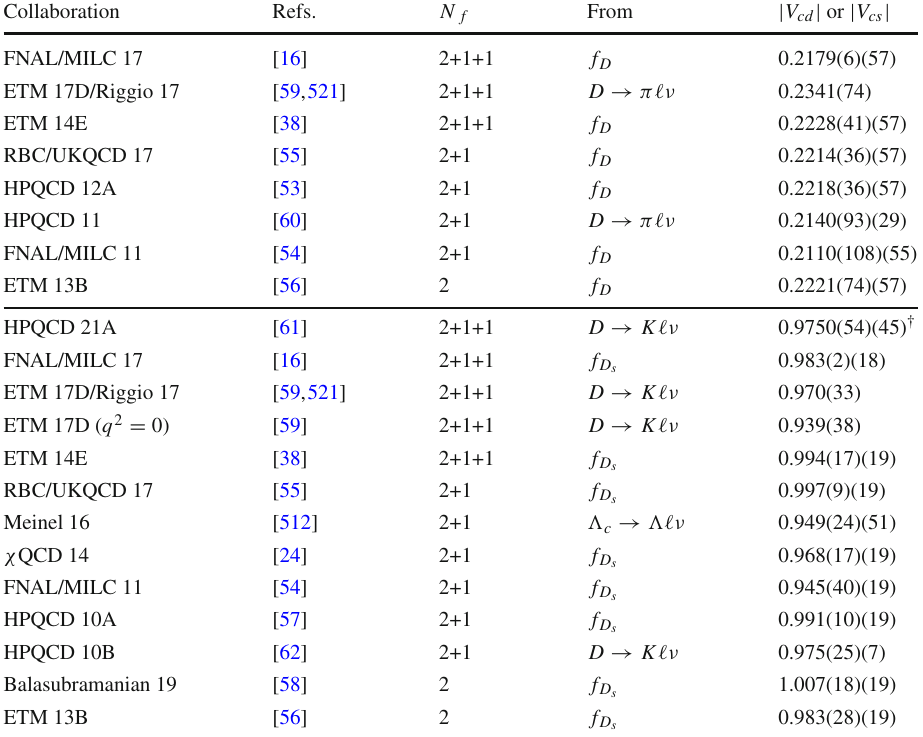
Table 38 Determinations of Collaboration | V | (upper panel) and | V | cd cs (lower panel) obtained from lattice calculations of D -meson leptonic decay constants and semileptonic form factors. The errors shown are from the lattice calculation and experiment (plus nonlattice theory), respectively, save for ETM 17D/Riggio 17, where the joint fit to lattice and experimental data does not provide a separation of the two sources of error (although the latter is largely theory dominated, like other results using D → π and D → K decays)